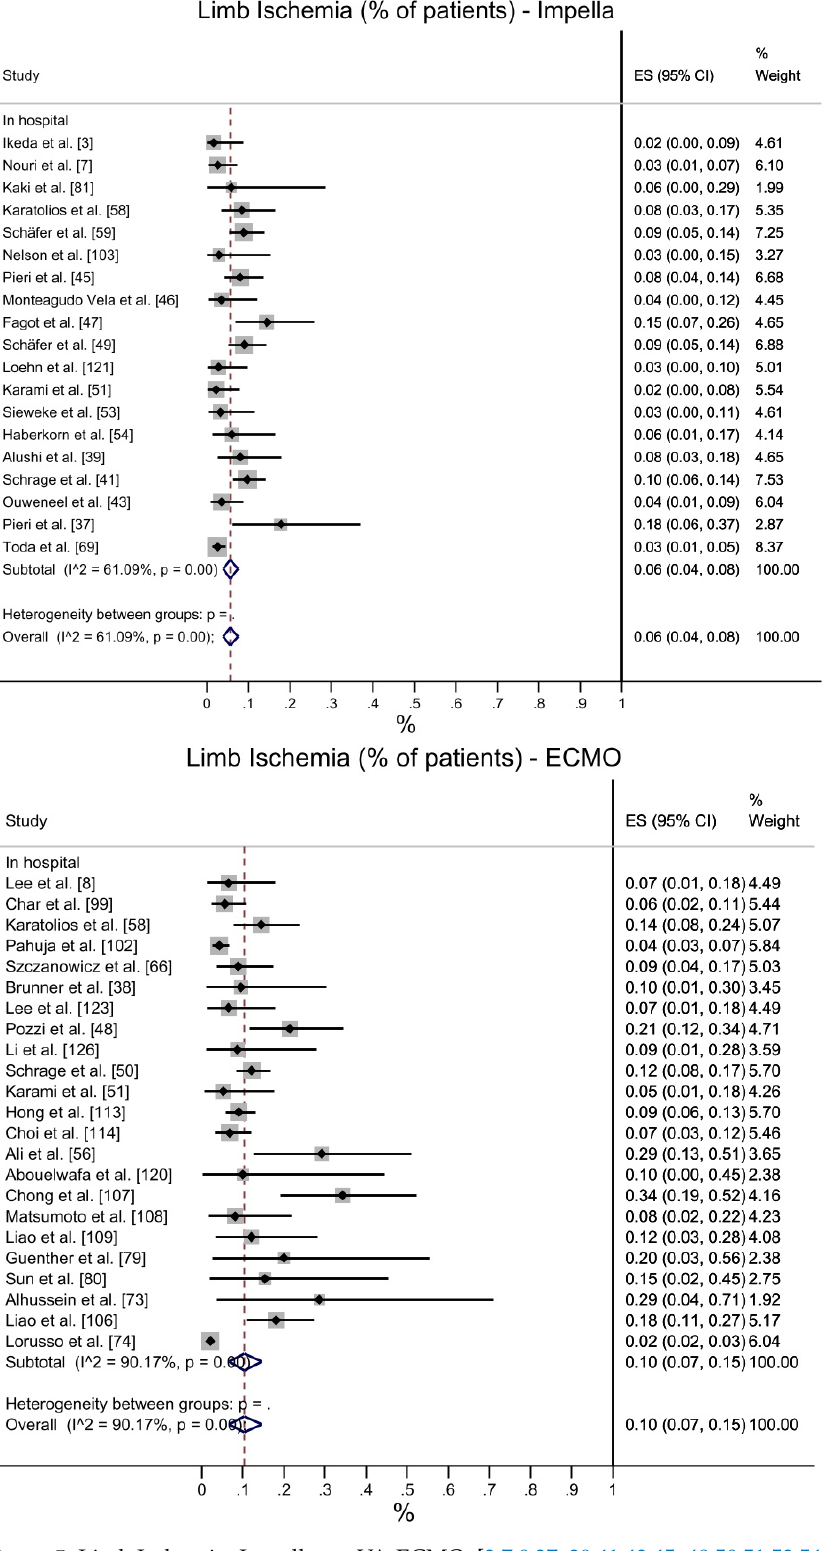
Figure 5. Limb Ischemia: Impella vs. VA-ECMO. [3,7,8,37–39,41,43,45- 48,50,51,53,54,56,58,59,66.69,73,74,79–81,99,102,103,106109,113,114,120,121,123,126]